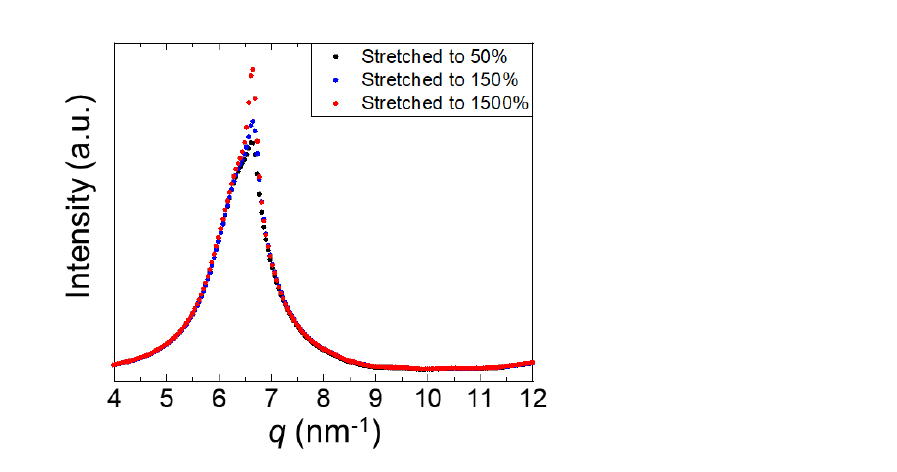
muthal angle are displayed. The intensity is in the arbitral unit.